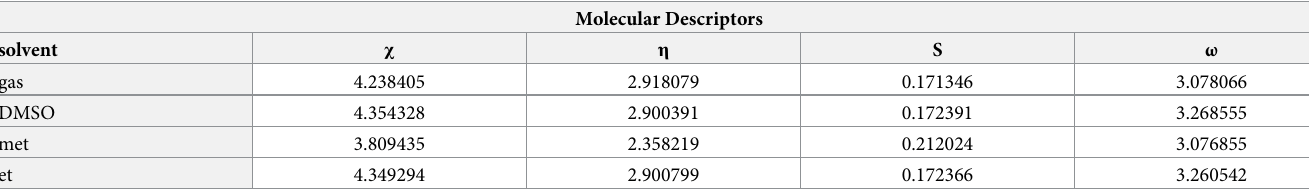
Table 3. Molecular descriptors values calculated by M062X/6-311++G ��